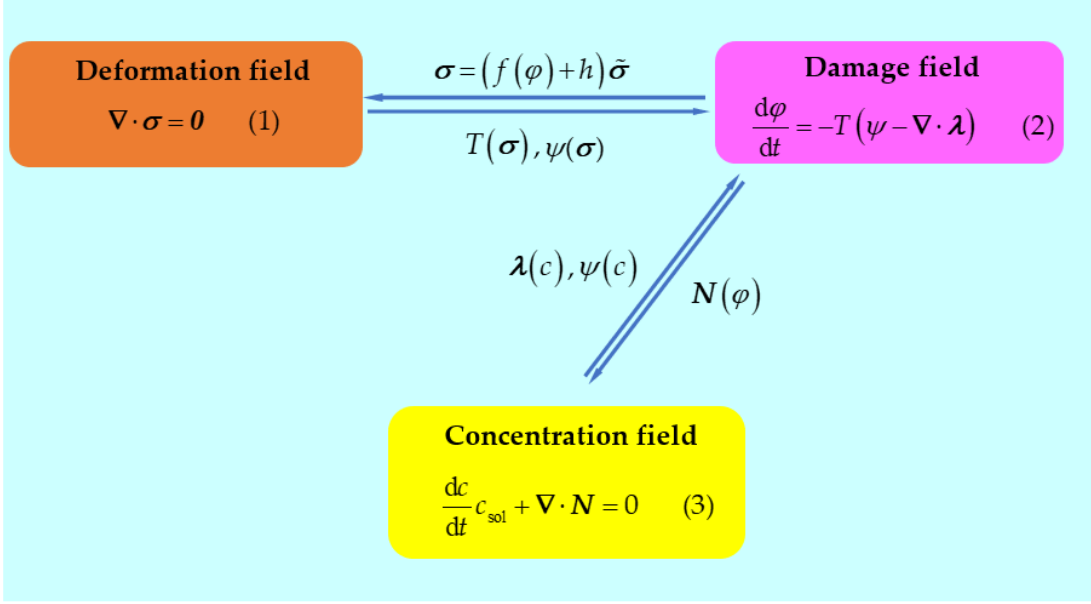
Figure 1. Schematic of multi-physical field coupling.